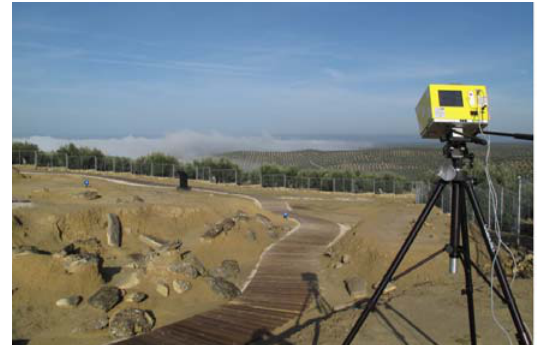
Figure 5. Optech ILRIS 3D TLS used for DEM acquisition (CP case).